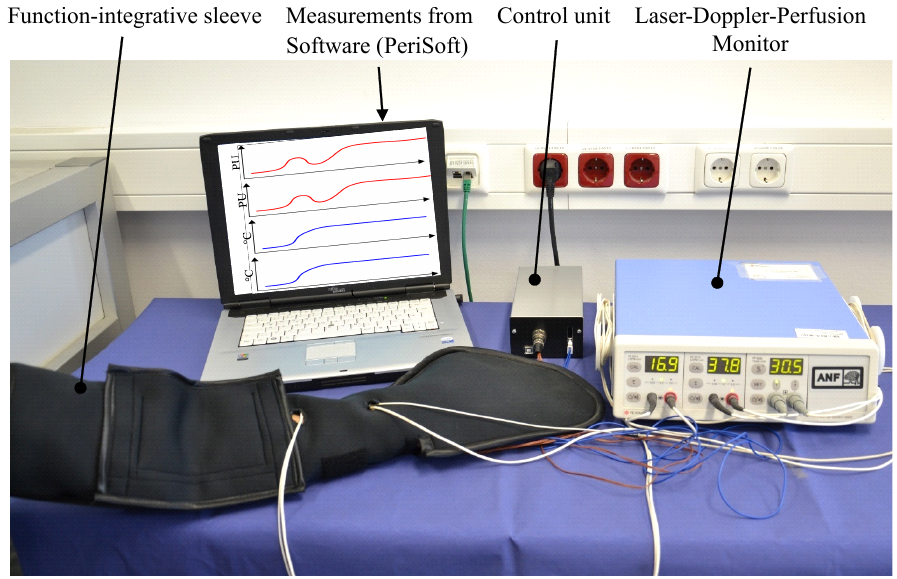
Figure 15. Illustration of blood flow measurement with local warming of the upper extremity using the function-integrative